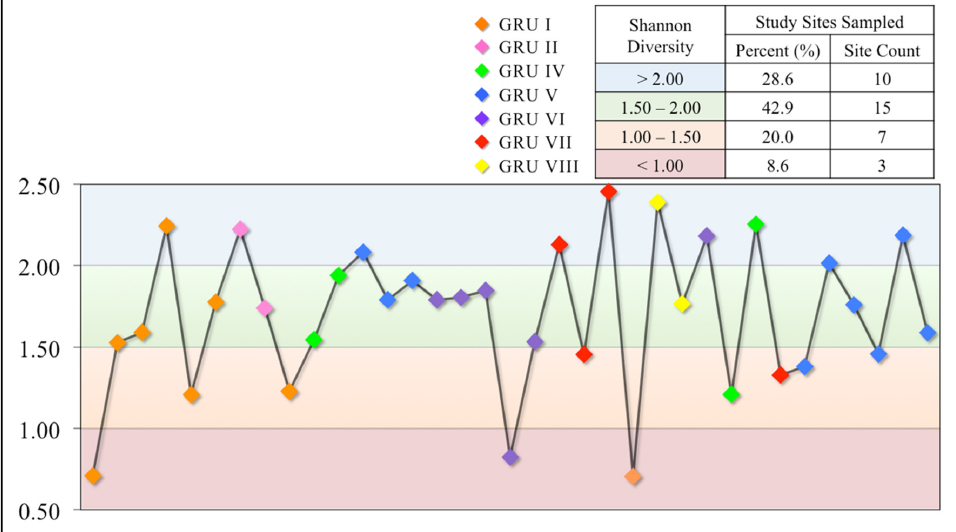
Figure 8. Shannon diversity index scores for each sampling site, displayed upstream to downstream, along the Qu’Appelle River. The GRU of each site can be found in the legend.